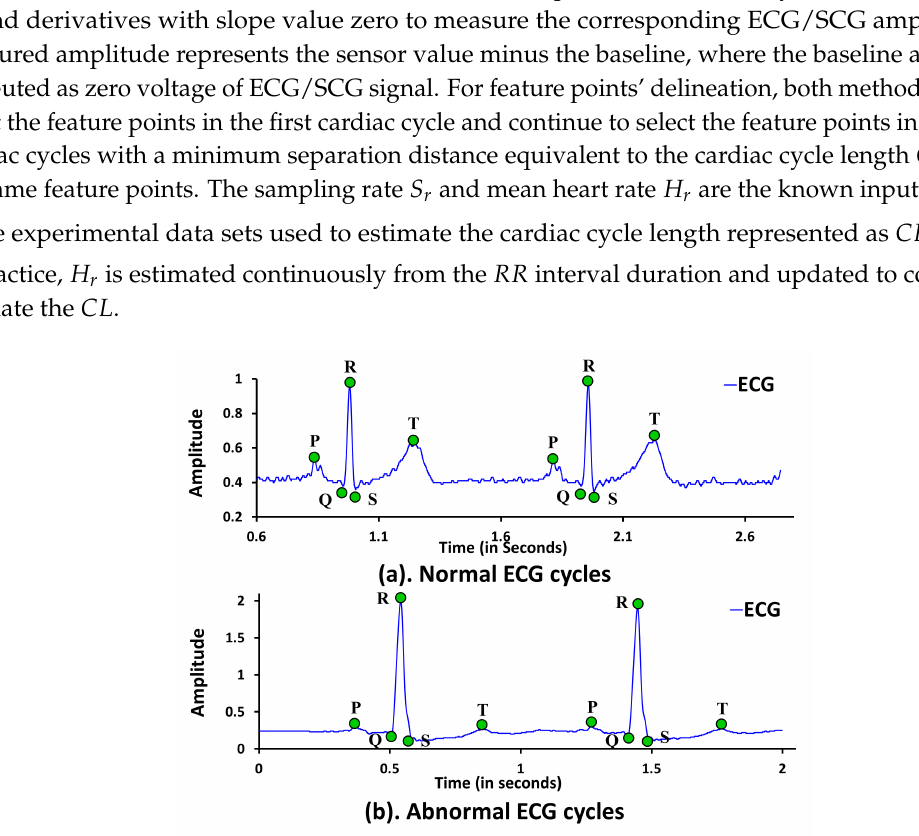
Figure 4. Feature points delineation in ( a ) normal ECG cycles; ( b ) abnormal ECG cycles.